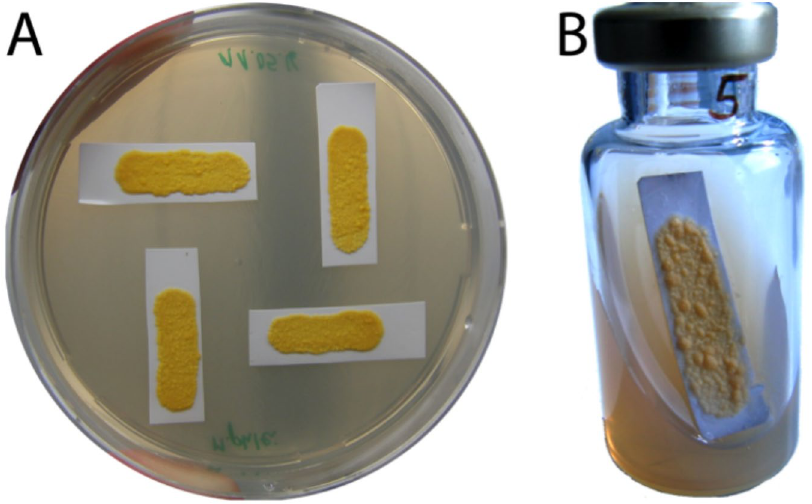
Figure 1. Picture of sample M. phlei biofilms prepared on 7H9 plates ( A ) and M. phlei biofilm prepared in a 20-ml calorimetric vial used for TDLAS measurements ( B ). Note that biofilms not reaching the required surface (at least 200 mm 2 ) were not used for the